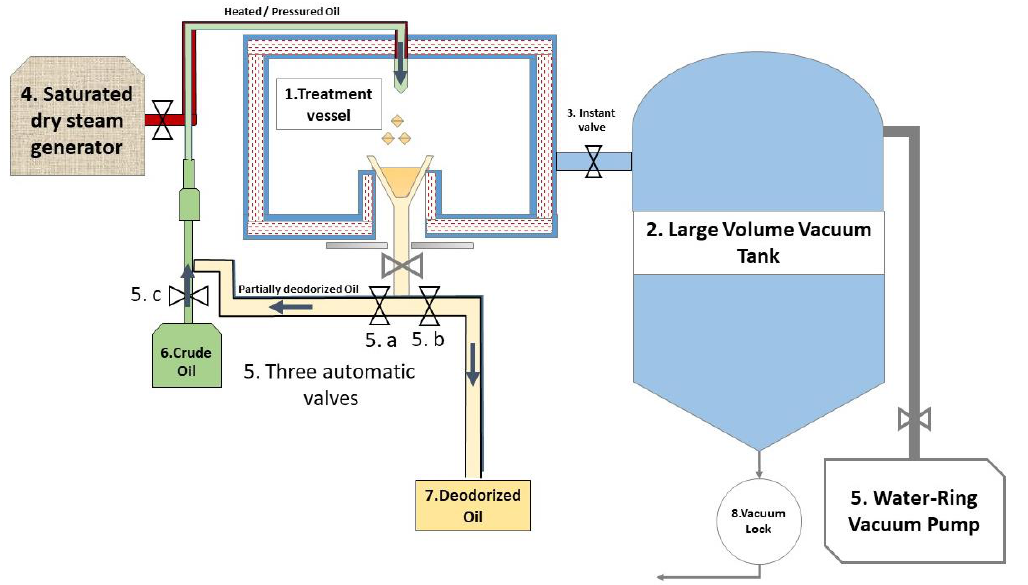
Figure 2. Schematic diagram of MFA industrial unit: 1/Vacuum vessel; 2/Large Volume Vacuum Reservoir; 3/Valve; 4/Saturated Steam Generator; 5/Automatic valves; 6/Crude oil tank; 7/Deodor- ized oil tank; 8/Vacuum lock; 9/Water-Ring Vacuum Pump.